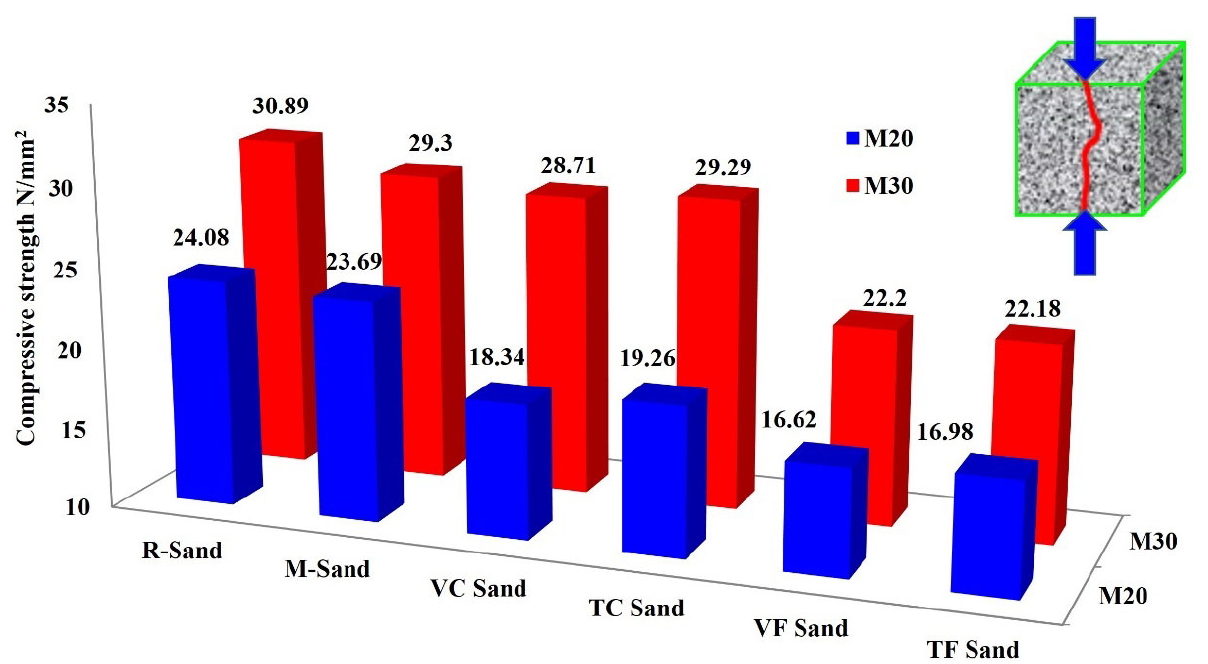
Figure 13. Compressive strength of concrete.